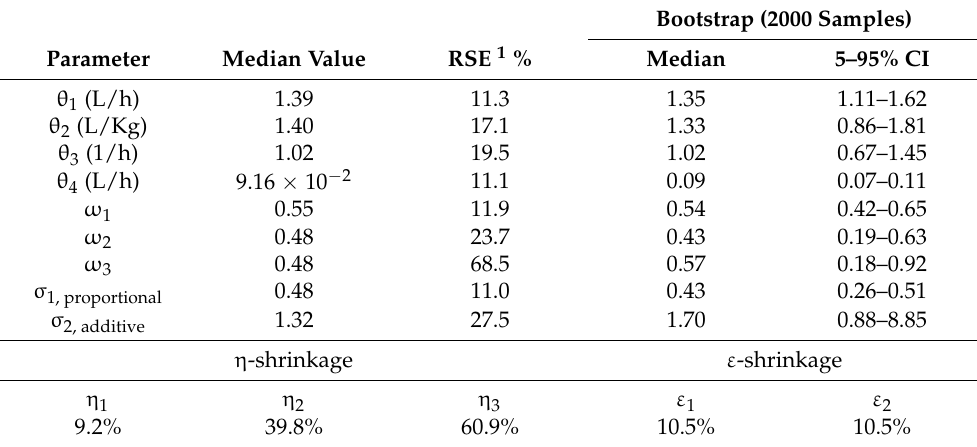
Table 3. Results of the final POP/PK model and bootstrap analysis performed in 2000 resam- pled